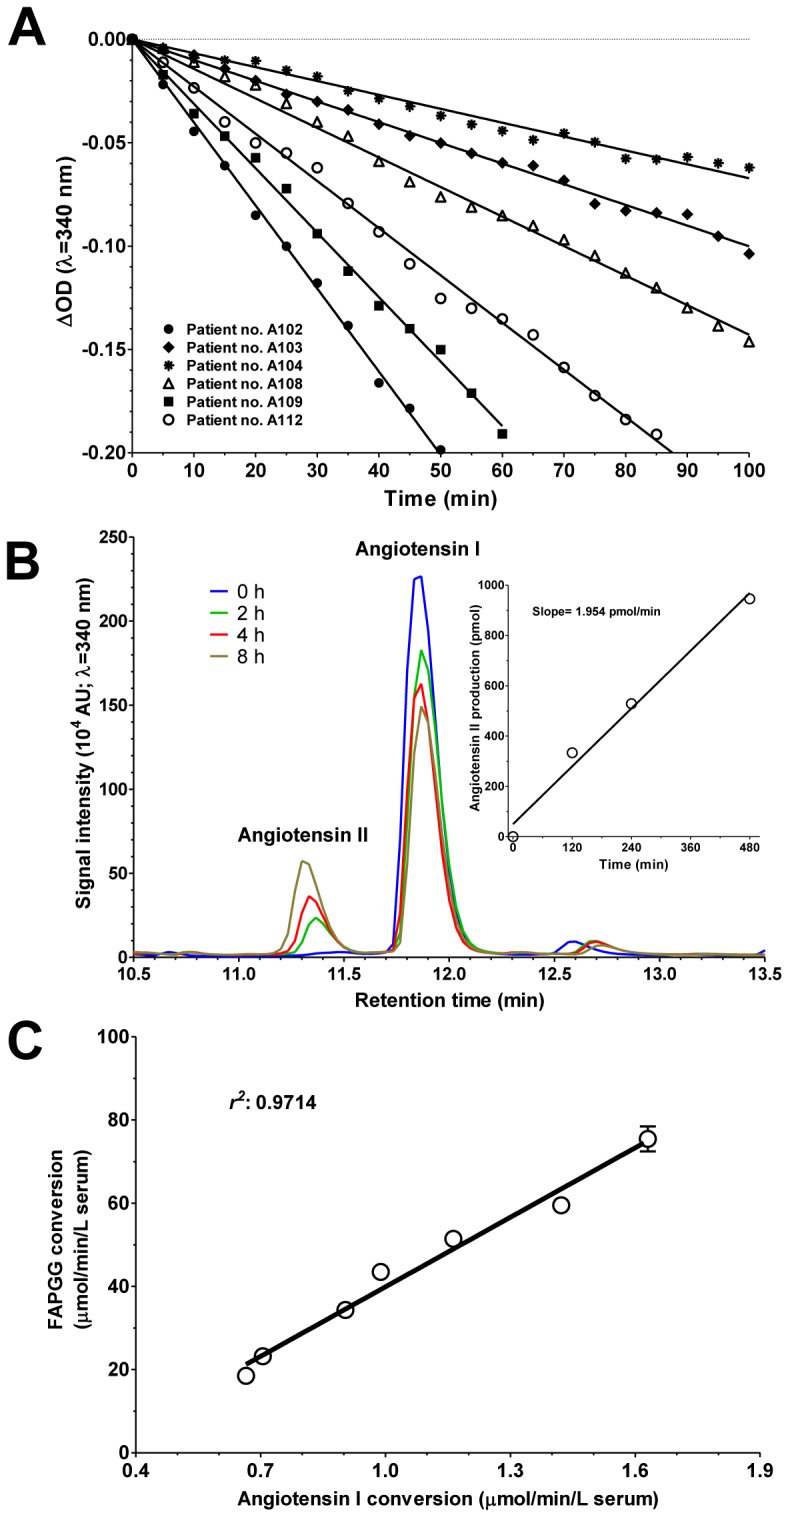
FAPGG hydrolysis proportional to angiotensin I conversion.A representative ACE activity measurement is shown in A. Decomposition of FAPGG results in a decrease in optical density at 340 nm. The decreases in optical density were plotted as a function of the reaction time and fitted by linear regression. The kinetics of decomposition was followed for at least 90 min. The slope of the linear regression was taken as a measure of the ACE activity. Determinations were repeated at least 3 times to obtain activity values. The ACE activity was also determined by using its endogenous substrate angiotensin I, which is converted to angiotensin II by ACE (B). This reaction was followed by HPLC. Area under the curve was calculated to quantify the amount of the peptides. Calibration plots were constructed based on standard concentrations of the peptides. Angiotensin I conversion was followed by a kinetic assay, where angiotensin I and angiotensin II were determined after 0, 2, 4 and 8 h. The slope of the linear fit gave the ACE activity. A single representative experiment is illustrated (B). Parallel experiments were performed to compare FAPGG and angiotensin I-converting activities of the same sample (C). FAPGG converting activities were plotted as a function of angiotensin I converting activities. Plots were fitted by means of linear regression (solid line), the symbols denote means ± SEM of 3 independent determinations. The goodness of fit (r2) is also indicated on figure.